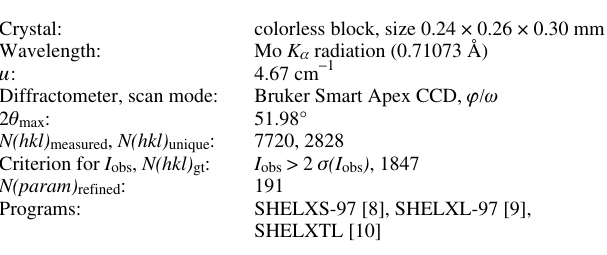
Table 1. Data collection and handling.